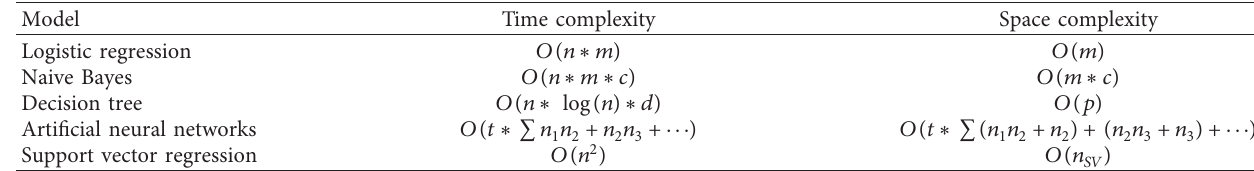
Table 2: The time and space complexity of common machine learning